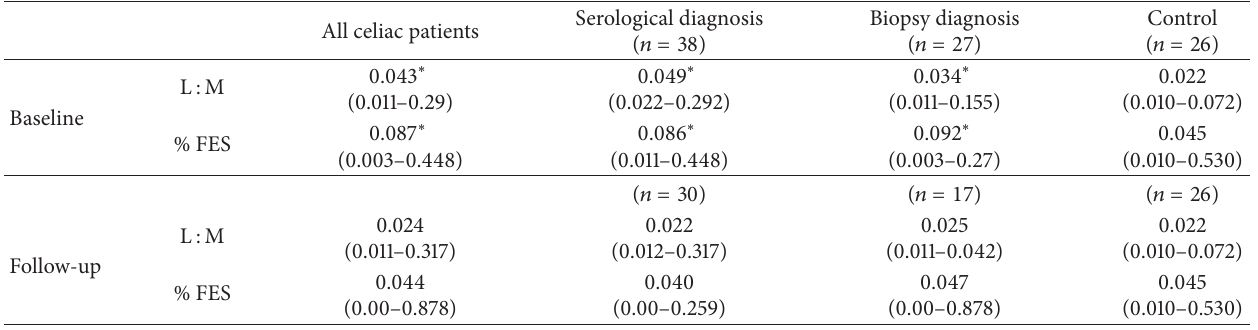
Table 2: Permeability results.